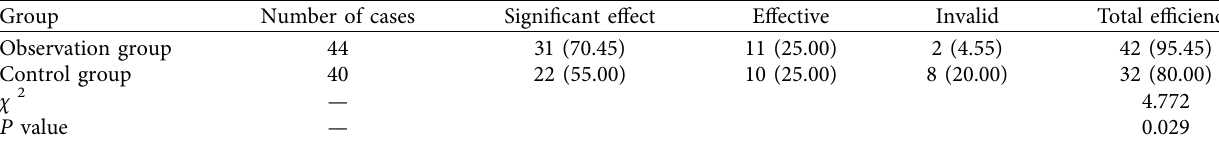
Table 2: Comparison of clinical efficacy between the two groups of patients ( n ,